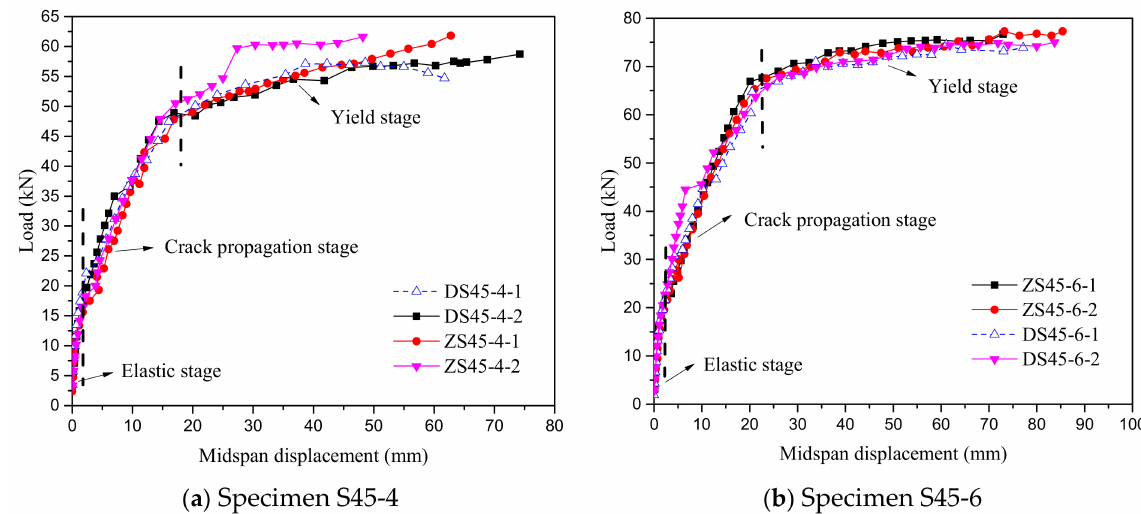
Figure 12. Load–midspan-displacement curves of steel–RPC composite plates.